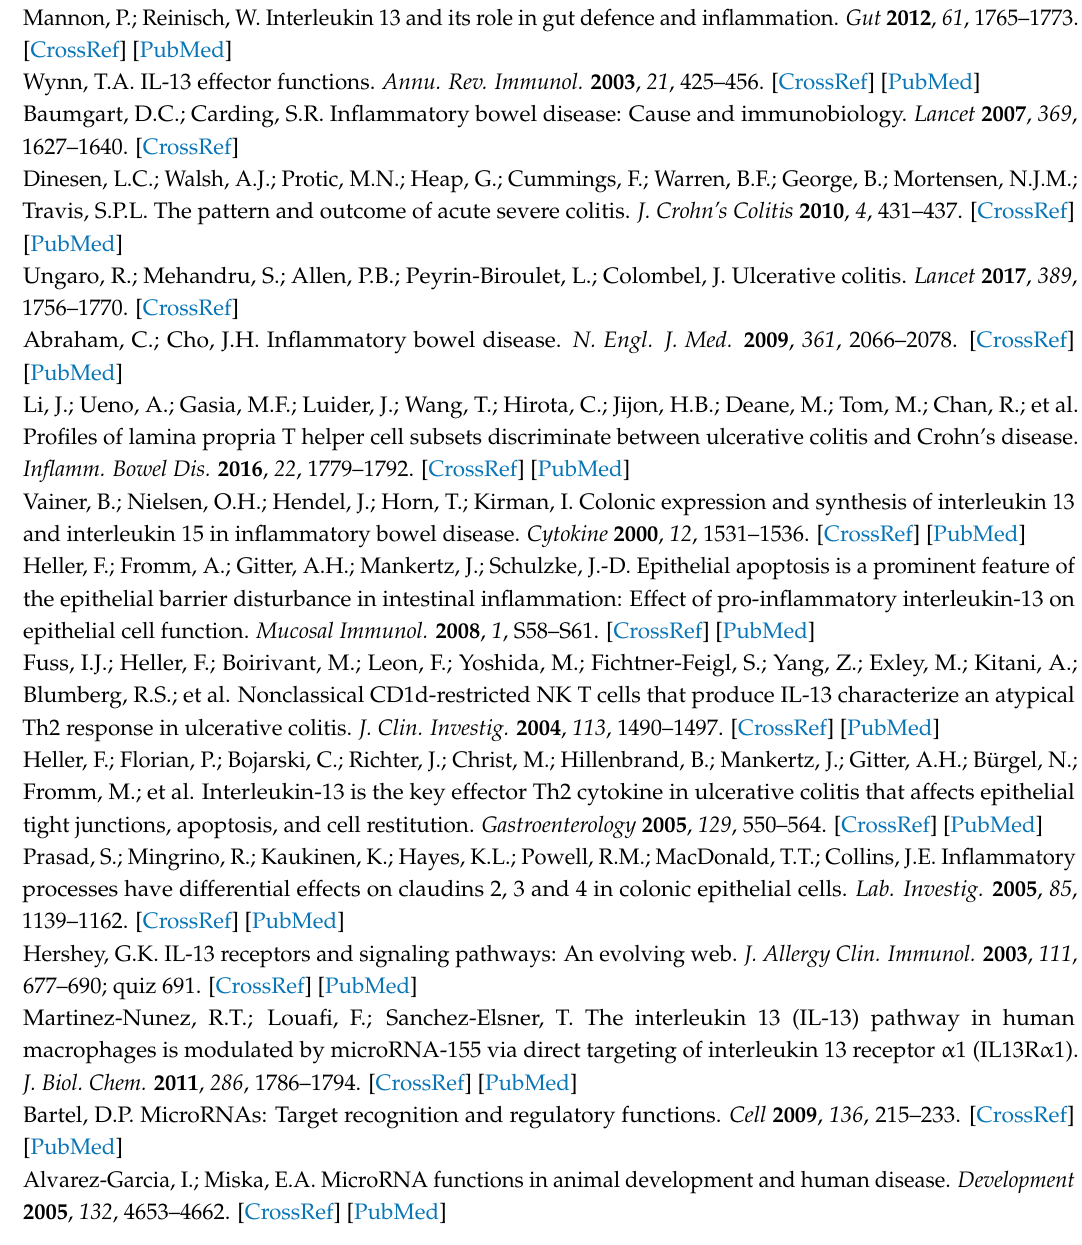
cells; Figure S5: IL-4 and IL-13 cytokine expression from colonic biopsies from patients with inactive or active UC compared to normal non-UC controls. Table S1: Predicted positions (TargetScan) of microRNA binding sites in the 3 (cid:48) UTR of IL13RA1 . Table S2: Demographic data of patients ELISA for IL-13 and IL-4 (Figure